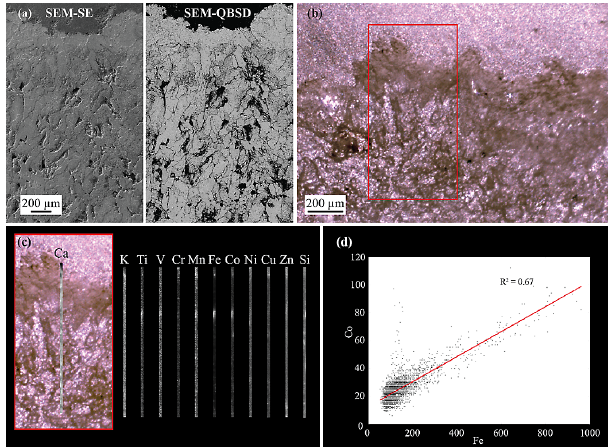
Fig. 7. (a) Cross-sectional micrographs of the outer surface and en- dolithic habitat under SEM-SE and SEM-BSE conditions. (a) Large void spaces exist beneath the surface crust, providing habitats for microbial colonization. Little contrast variability imaged by SEM- BSE suggests the entire habitat to be composed of gypsum. (b) Light micrograph showing weathered outer surface (dark-colored areas) and subsurface habitat. Boxed area highlighted in (c) , with µ- XRF transect from exposed surface down into the endolithic habitat. While calcium dominates, metals are heterogeneously distributed throughout the microenvironment. (d) Co-location analysis shows only a weak relationship between Co and Fe, which are likely de- rived from allochthonous debris. Lack of a spatial correlation be- tween metals and microorganisms suggests that bacteria are not in- volved in chemical weathering of the endolithic